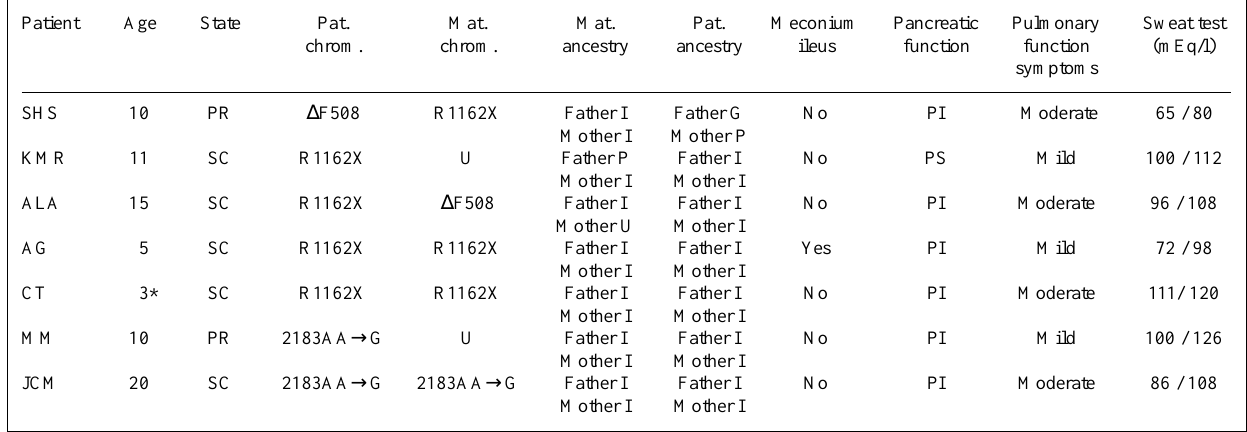
Table I - Clinical symptoms in patients who are carriers of the mutations